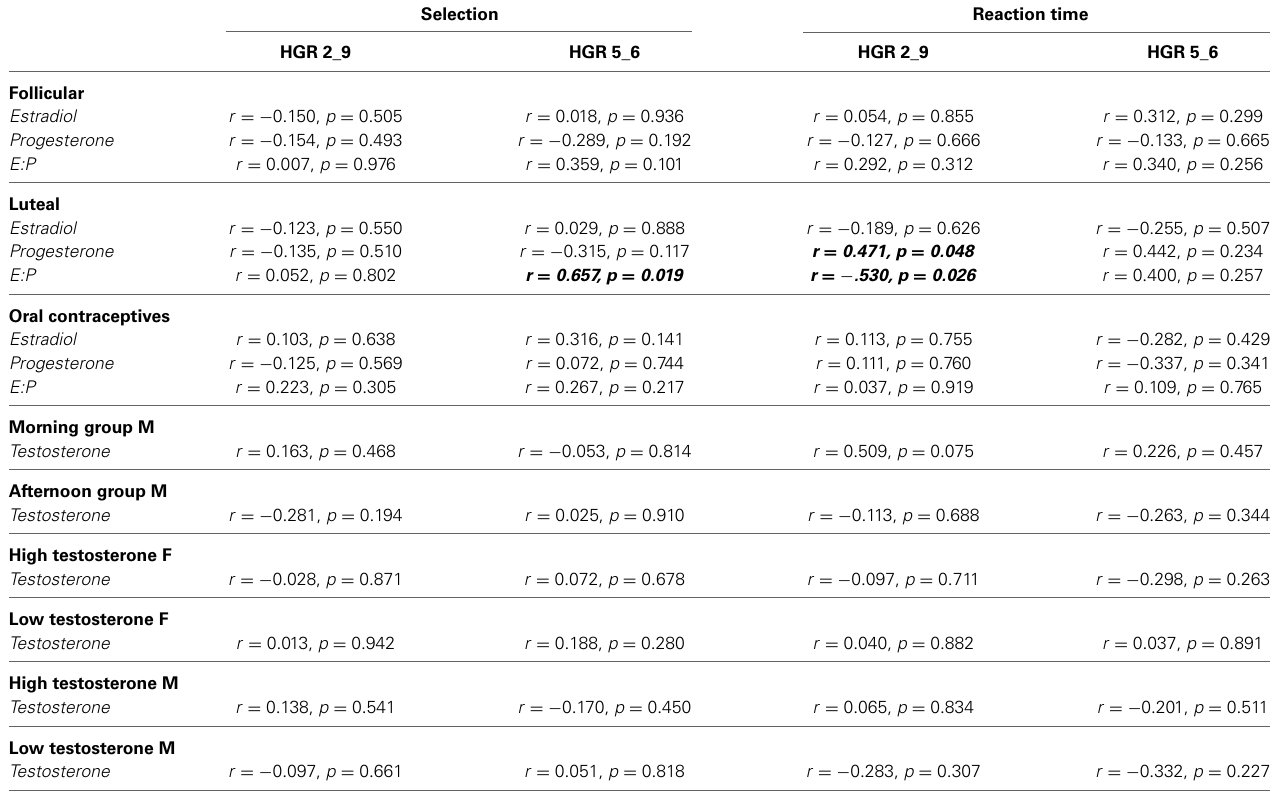
Table 2 | Overview on correlations between hormone concentrations and behavioral performance (selection as well as reaction times) for all